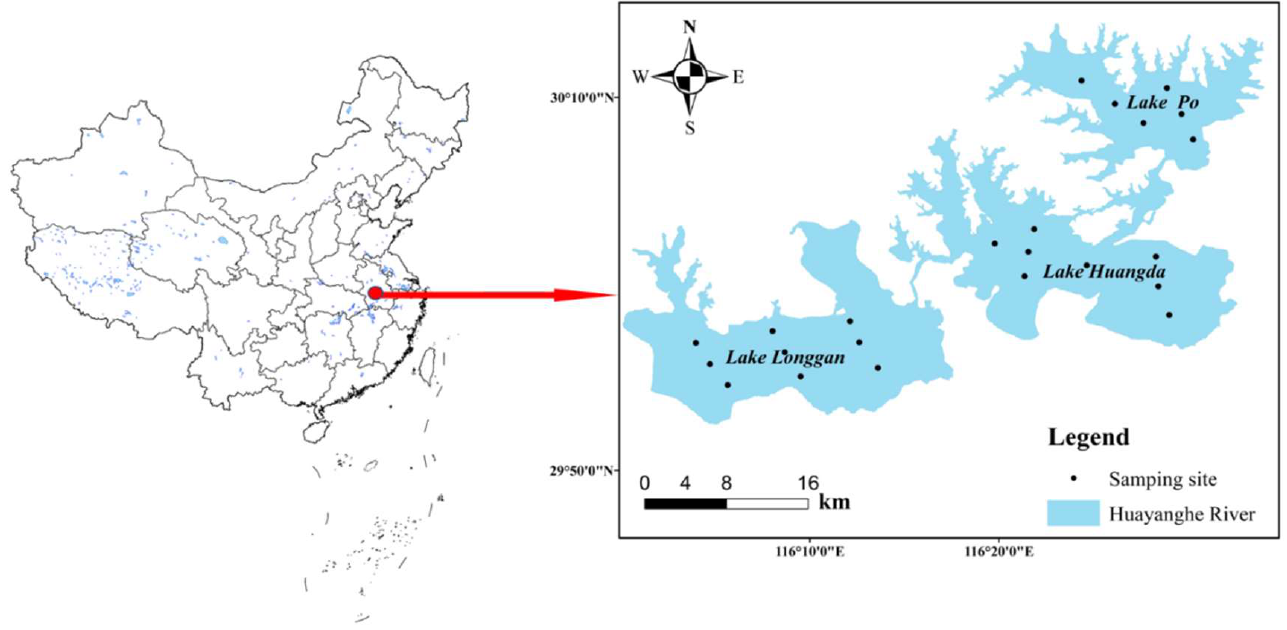
Figure 1. Map of the study area and sampling sites.